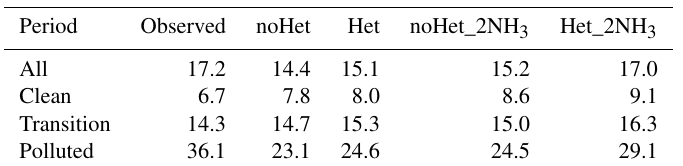
Table 2. Observed and simulated sulfate concentrations (µgm − 3 ) for different scenarios by clean, transition, and polluted periods at the SAES site during 1 to 29 December 2013.